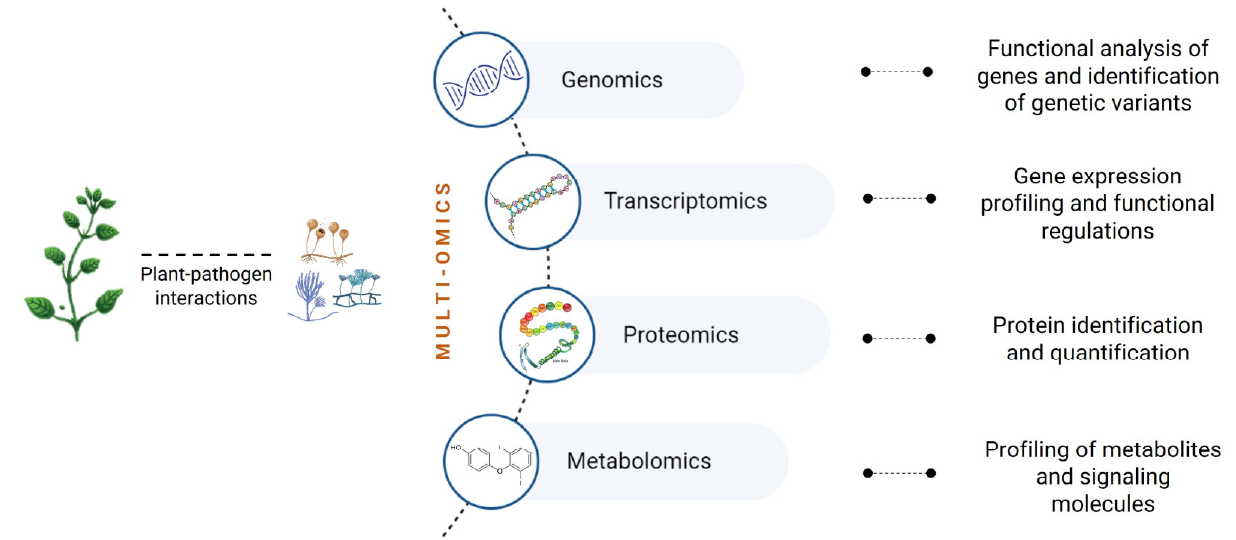
Figure 1. Multi-omics approaches and obtained data for a thorough understanding of diverse as- pects of plant pathogens and their cross-talks with plants.